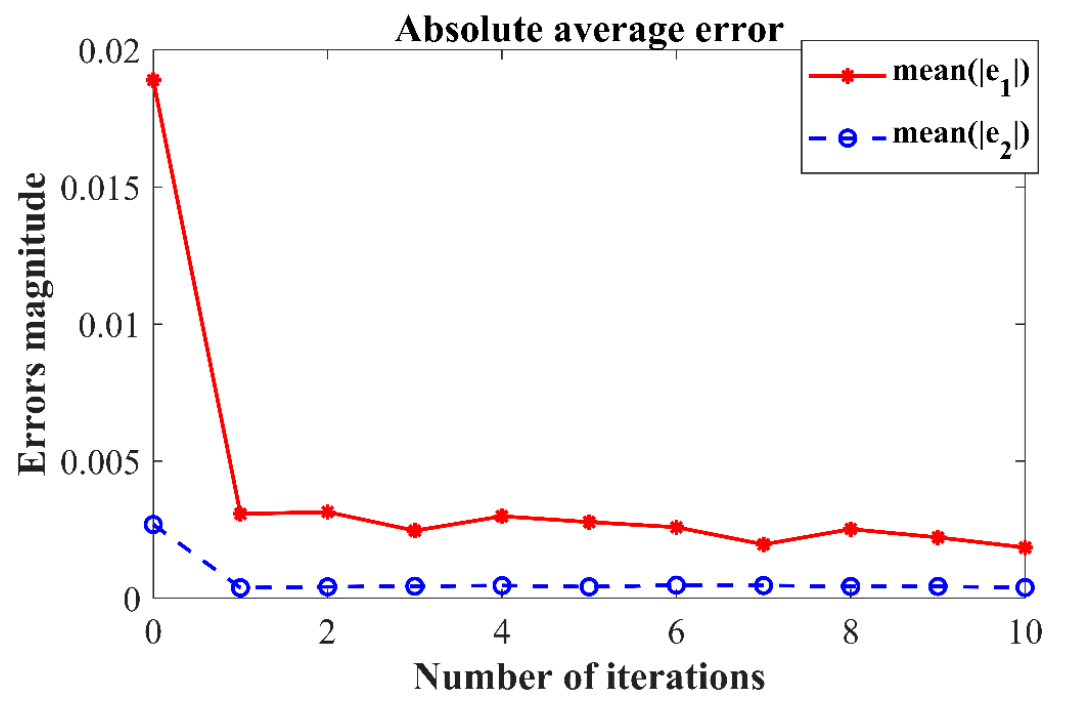
Figure 8. Iterative error convergence trend.